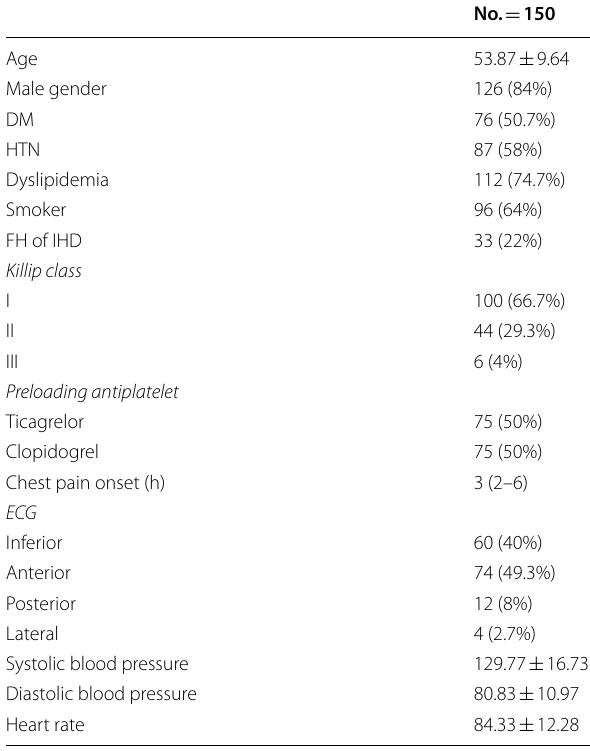
DM, diabetes mellitus; FH of IHD, family history of ischemic heart disease; HTN,